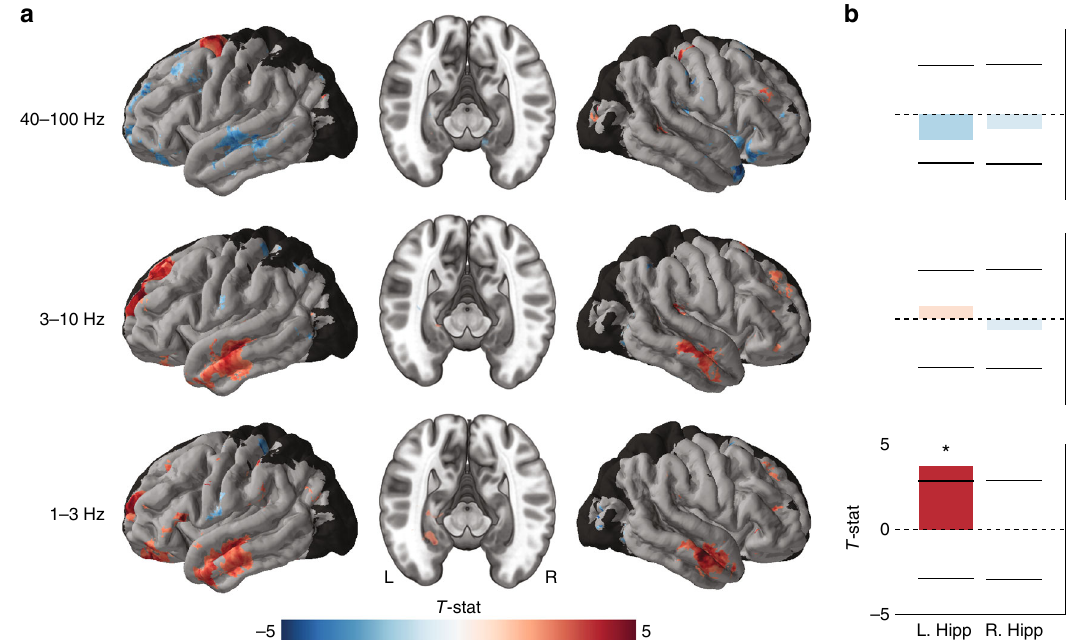
Fig. 3 Group level memory-related changes in spectral power in three frequency bands. Red indicates greater power for viewing an item that was subsequently recalled compared to an item that was not recalled, blue indicates greater power for not recalled items. Color corresponds to the t -statistic from comparing the distribution of subject-level effects to zero. a Cortical surface plots and hippocampal cross sections of signi fi cant changes in memory- related power during item encoding, thresholded using a permutation procedure (see Methods). Non-signi fi cant areas are in gray. Neocortical regions with less than fi ve subjects were not included and are rendered in black. Cross-sectional plots show only data from electrodes localized to the hippocampus. b T -statistics averaged across the whole left ( N = 26) and right ( N = 21) hippocampi. Horizontal bars represent the critical t value for signi fi cance, determined by the degrees of freedom of that ROI and a Bonferroni